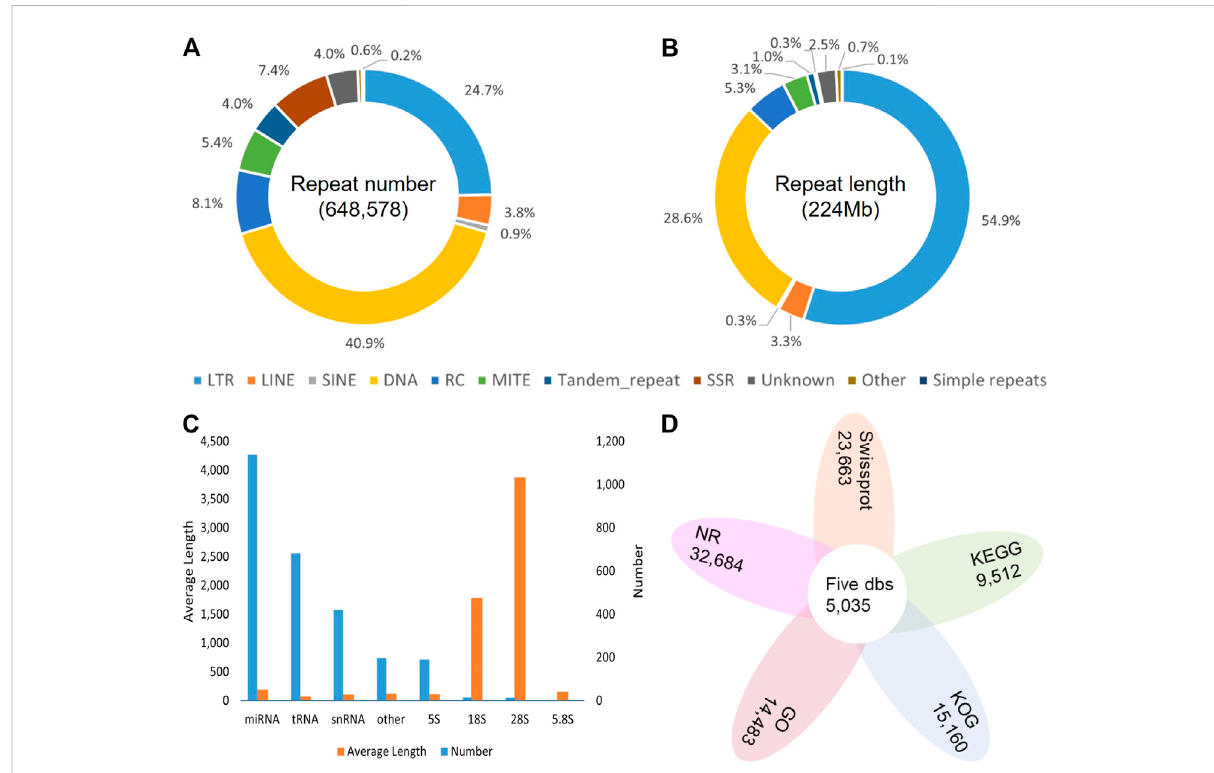
FIGURE 3 Genome annotation of DXWR. (A) The proportion of repeat classes in the total number of annotated repeats. (B) The proportion of repeat classesinthetotallengthofannotatedrepeats. (C) TheNumberandaveragelengthofNon-codingRNAs. (D) Thegenenumbersannotatedbypublic